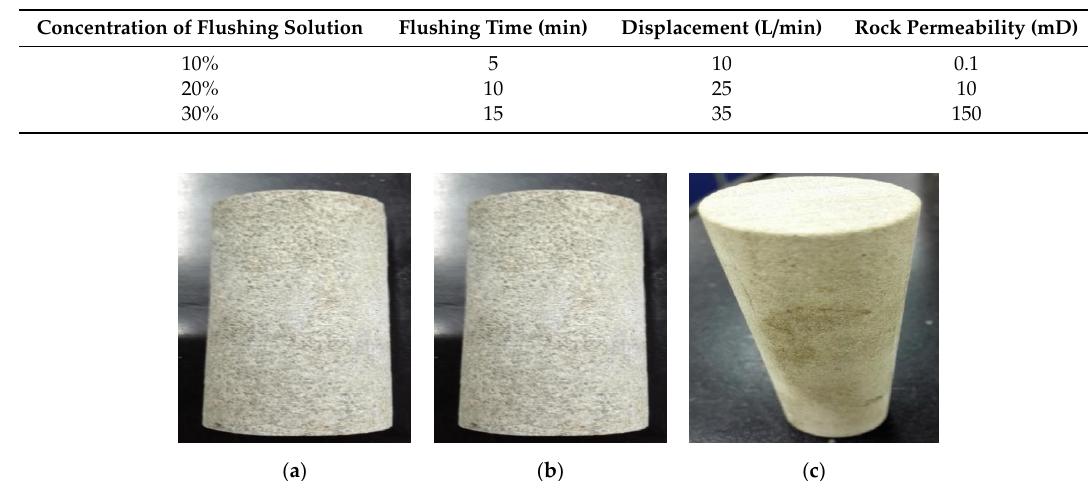
Table 1. Design of flushing experiment scheme.